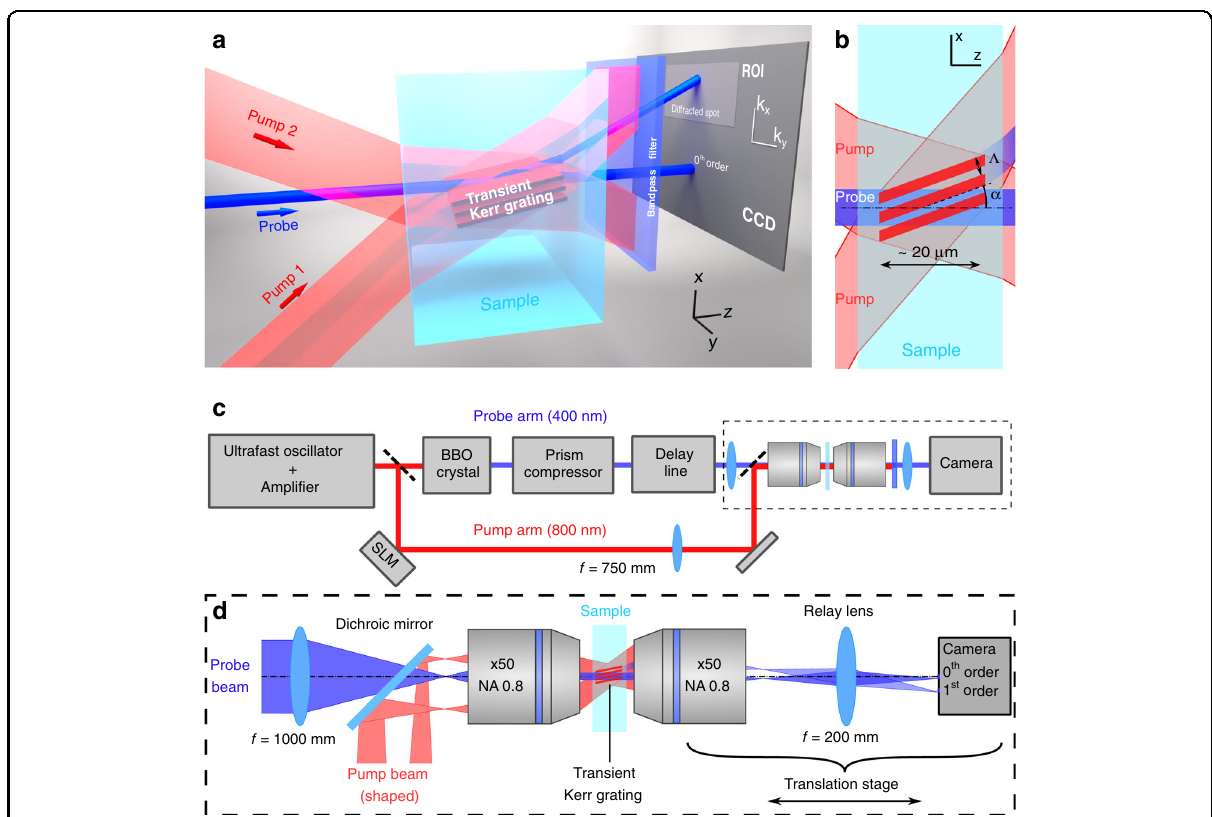
Fig. 1 Concept and setup. a Concept of the transient grating induced by the shaped infrared pump pulse in a transparent dielectric. The probe signal diffracted by the transient grating is collected in the far- fi eld. b The Kerr-induced transient grating has a period Λ and is tilted with respect to the probe axis by an angle α . The length of the transient grating is a few tens of microns while the sample can be much thicker. c Experimental setup design. d Magni fi ed view of the setup in the dashed box of ( c ) to show the interacting beams and the imaging con fi guration. In the interaction region, the beams are in plane-wave con fi guration. They are, therefore, focused in the back focal plane of the microscope objective. The relay lens images the back focal plane on the camera with a magni fi cation factor of 1. The focal length of the microscope objectives is 3.6